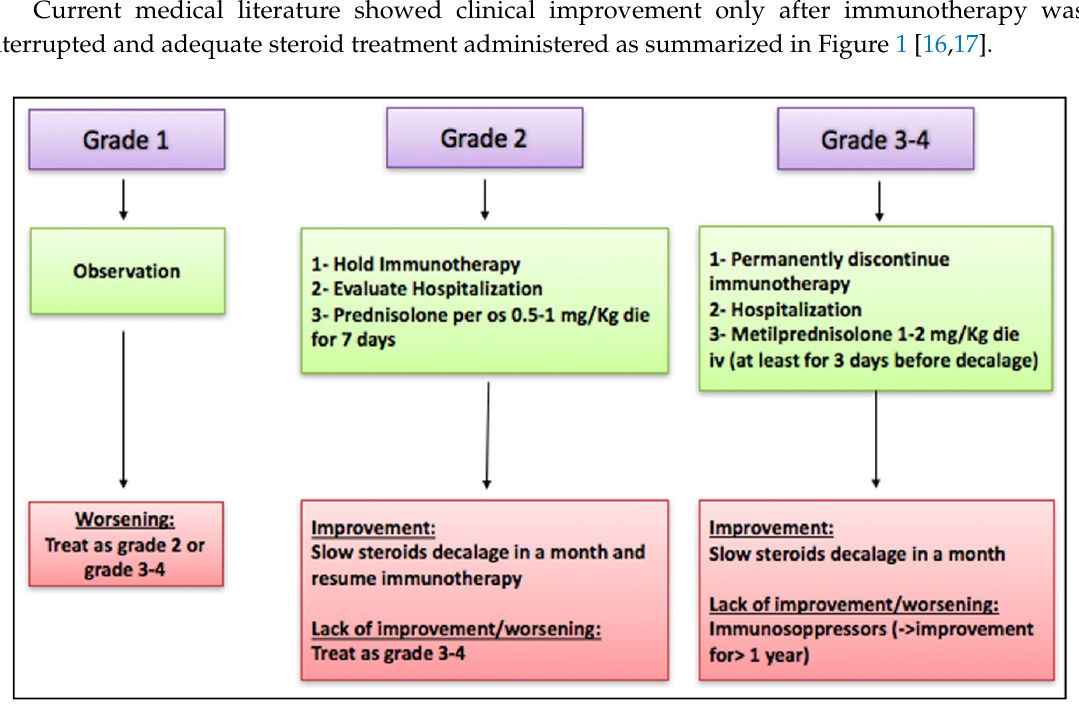
Figure 1. Neurological immune-related adverse events (irAEs) management guidelines.